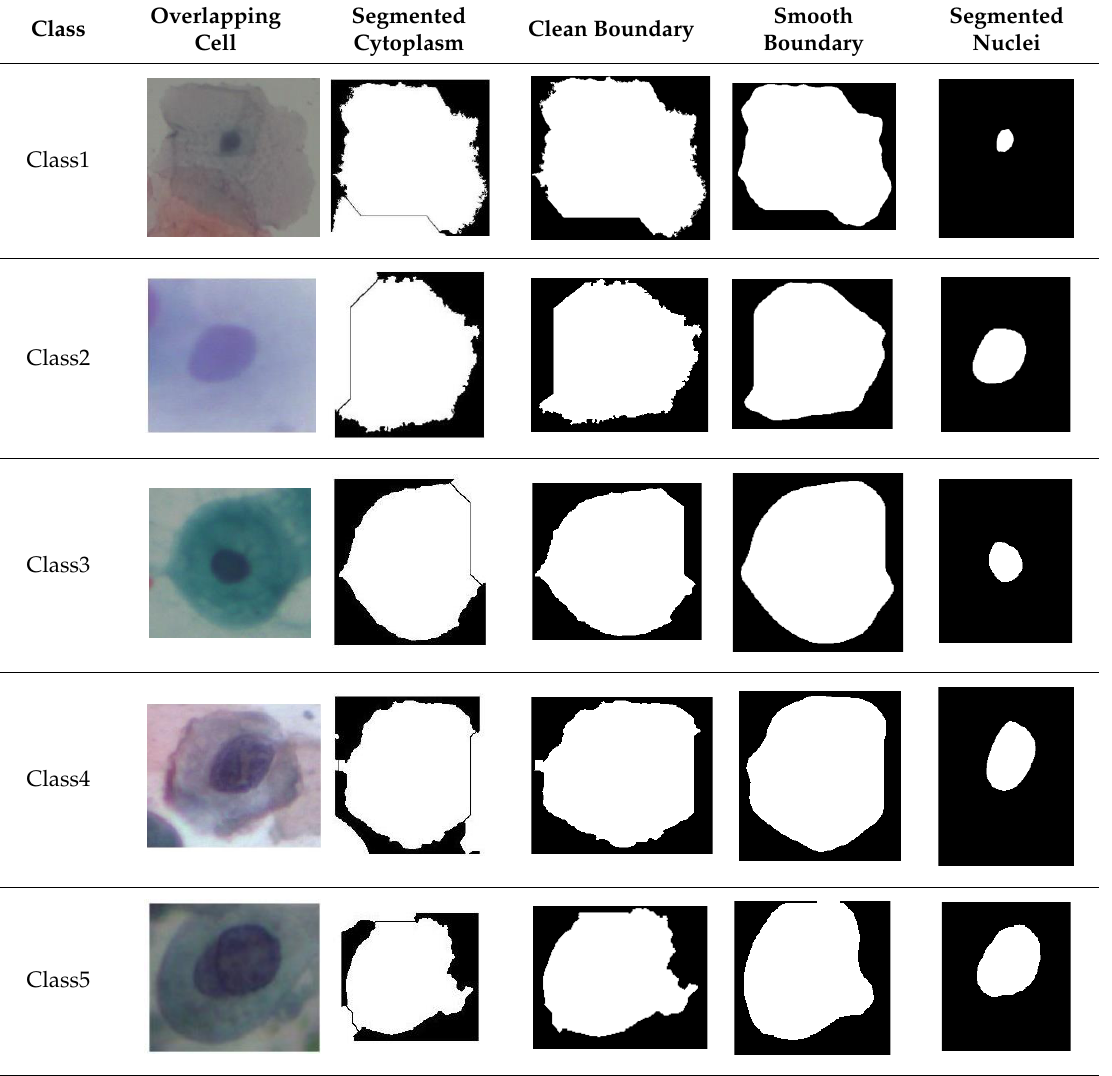
Table 10. The rate of well-segmented cytoplasm in terms of the number of cytoplasms. Isolated Cytoplasm